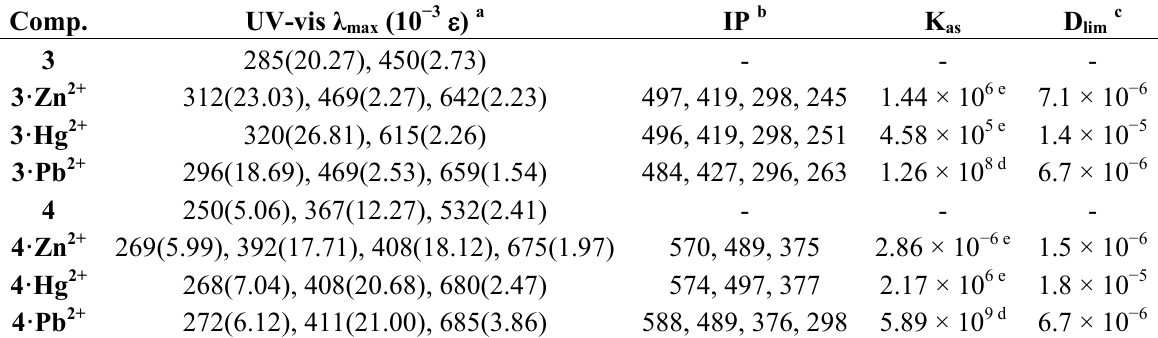
Cl ) upon addition 2 2 CN) until 2 equiv. 3